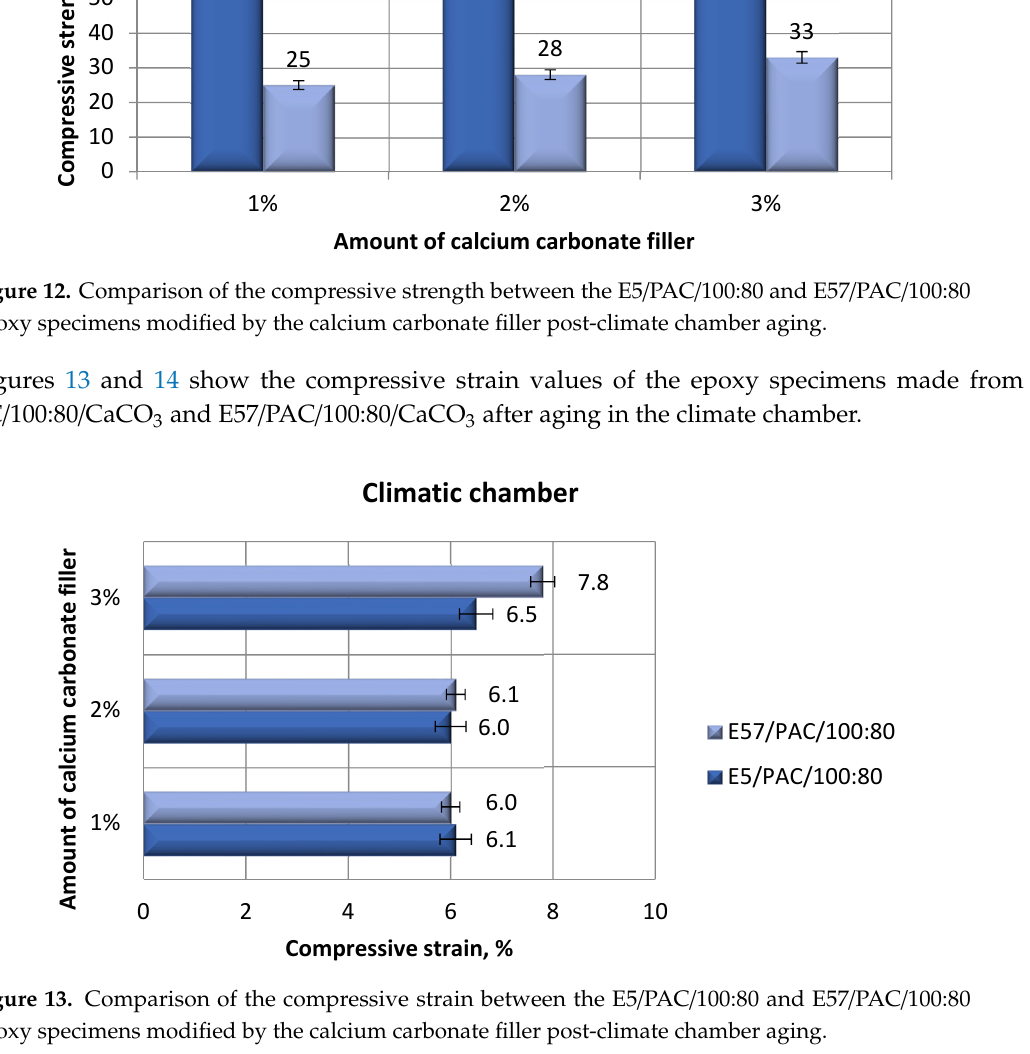
epoxy specimens modified by the calcium carbonate filler post ‐ climate chamber aging.